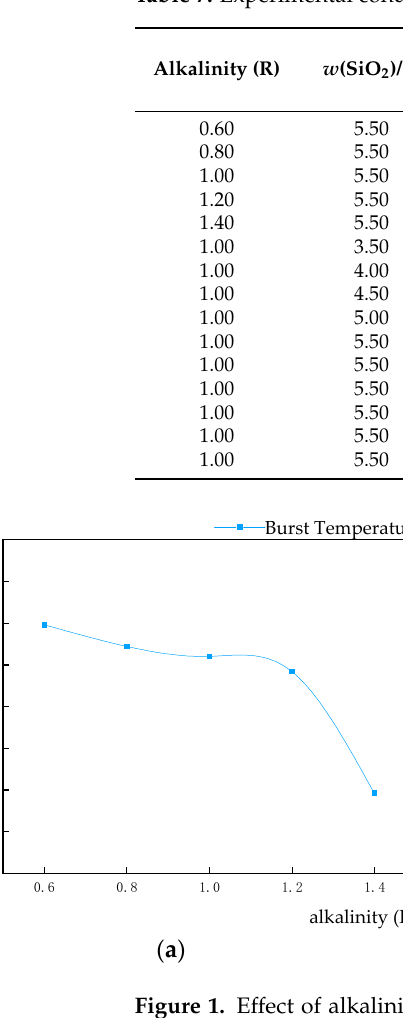
Table 7. Experimental conditions and green pellet performance data.